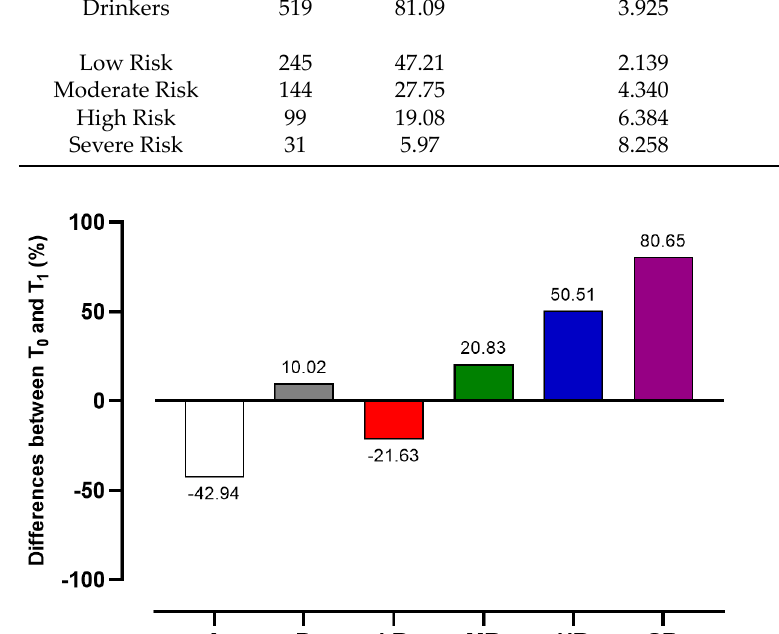
Figure 1. Differences in the percentage of subjects who consumed alcohol in the two times considered. A = Abstainers; D = Drinkers; LR = Low Risk; MR = Moderate Risk; HR = High Risk; SR = Severe Risk.